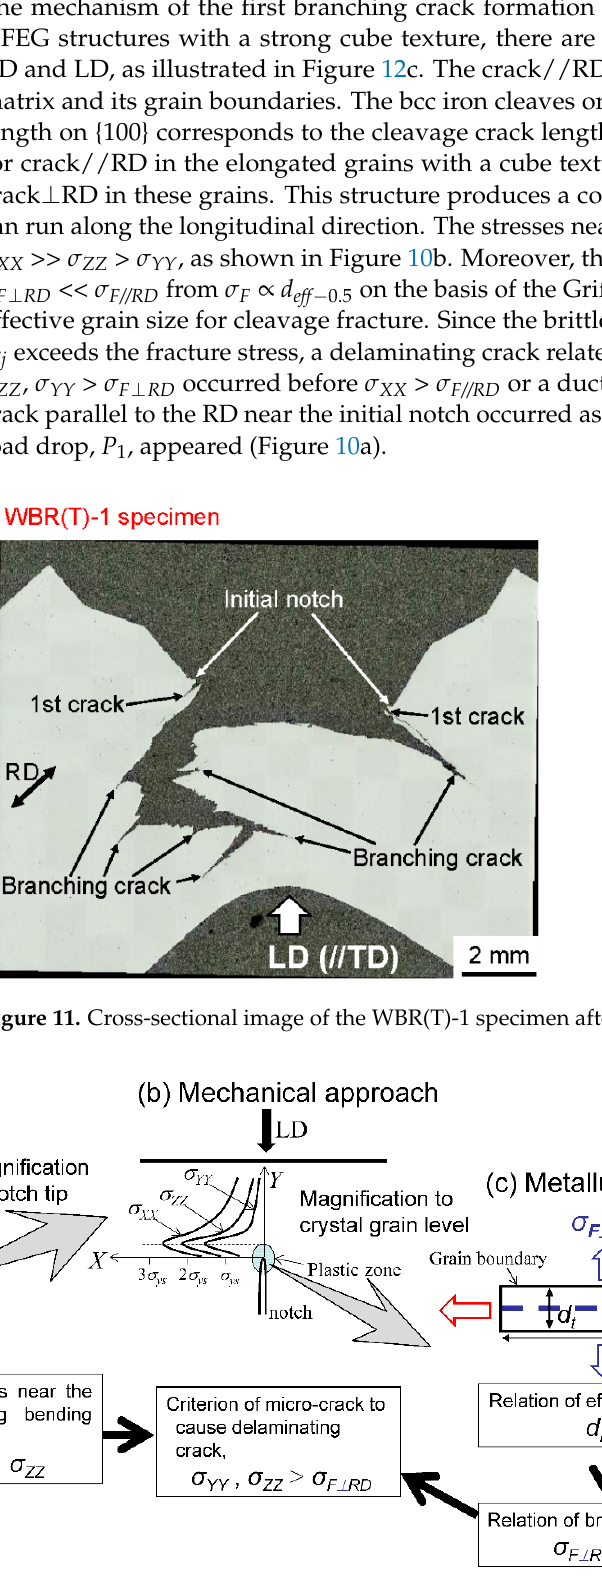
Figure 12. Schematic illustrations of ( a ) three-point bending test, ( b ) the stress states near the initial notch, and ( c ) the microstructure and the cleavage stresses in elongated-grain steel with a cube texture.